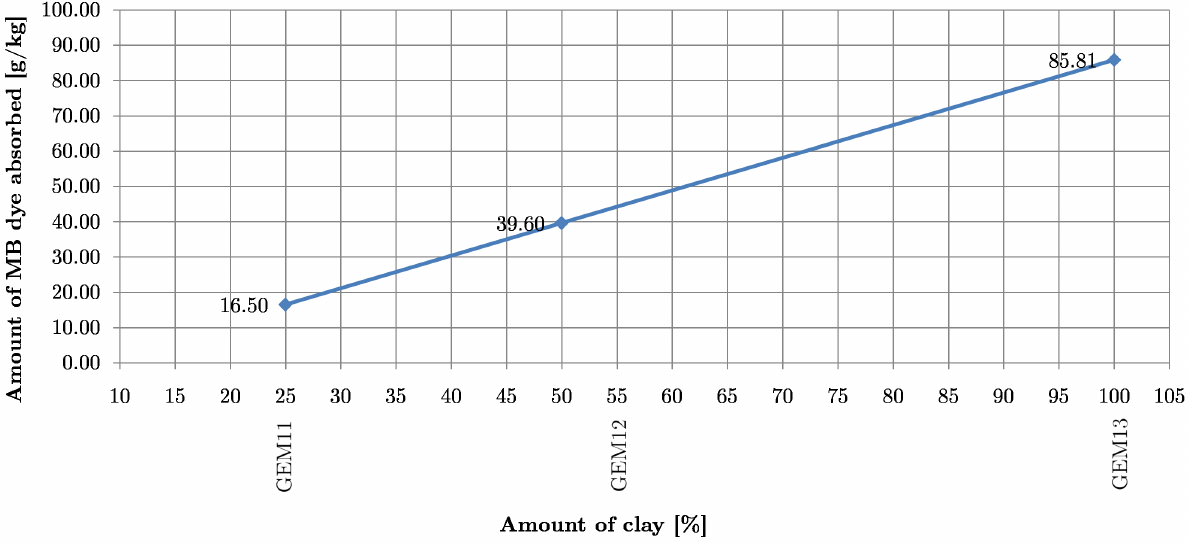
Figure 8. Dependence between amount of clay in earth samples and amount of MB dye absorbed. m MB, 1 ml Amount of methylene blue in 1 g of